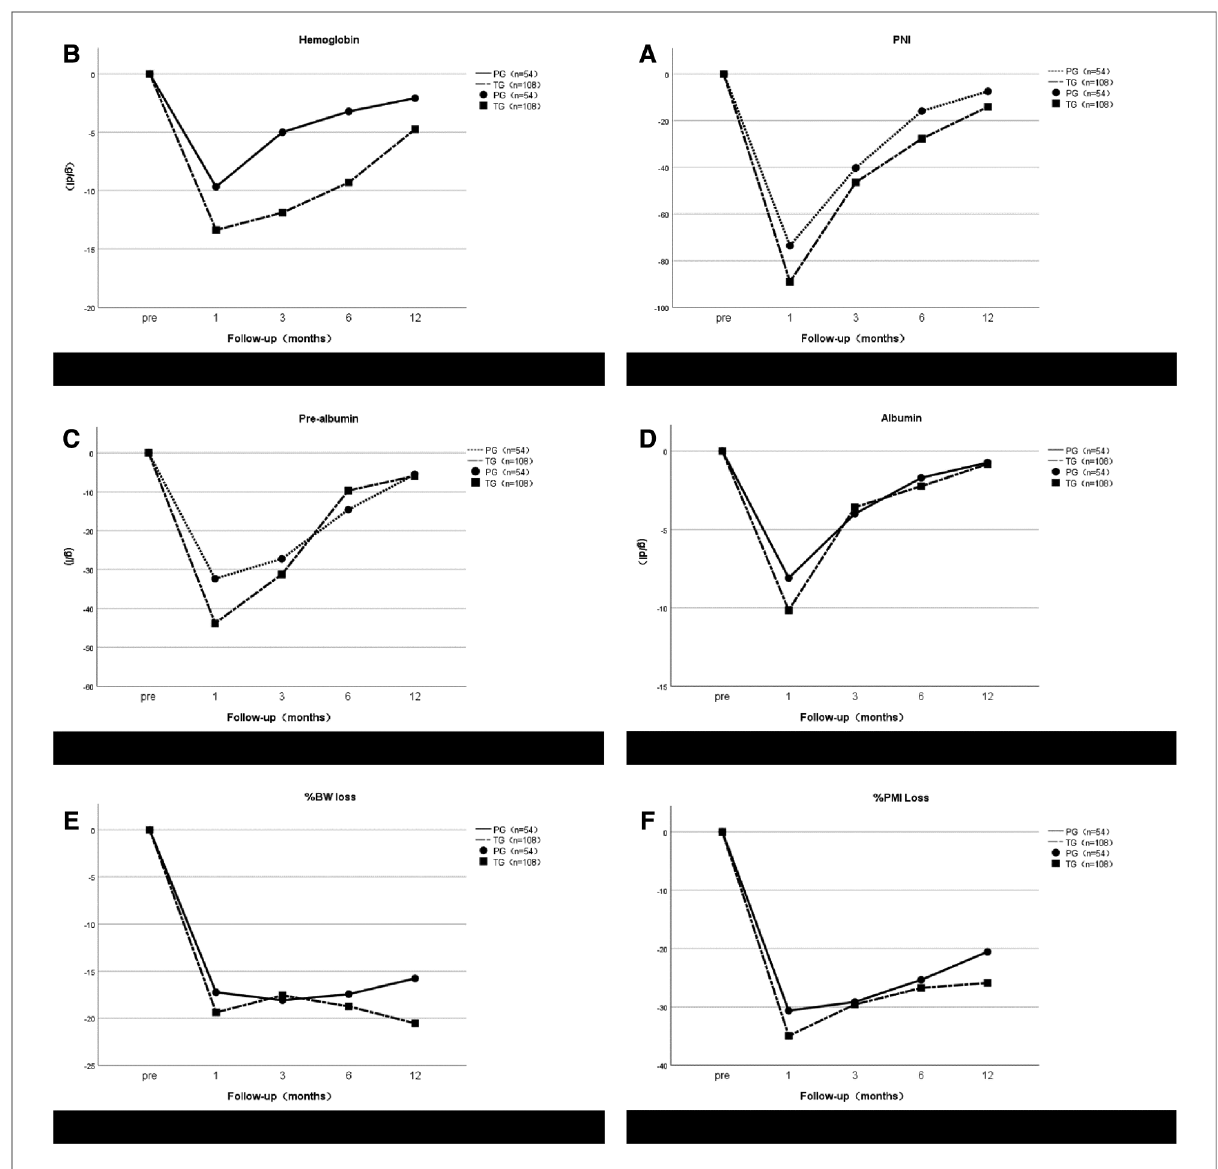
FIGURE 4 Postoperative changes of prognostic nutritional index (PNI) ( A ), hemoglobin ( B ), pre-albumin ( C ), albumin ( D ), %BW loss ( E ) and %PMI loss ( F ) in the proximal gastrectomy (PG) group and total gastrectomy (TG) group. All postoperative data are represented as values (mean±standard error) relative to preoperative.